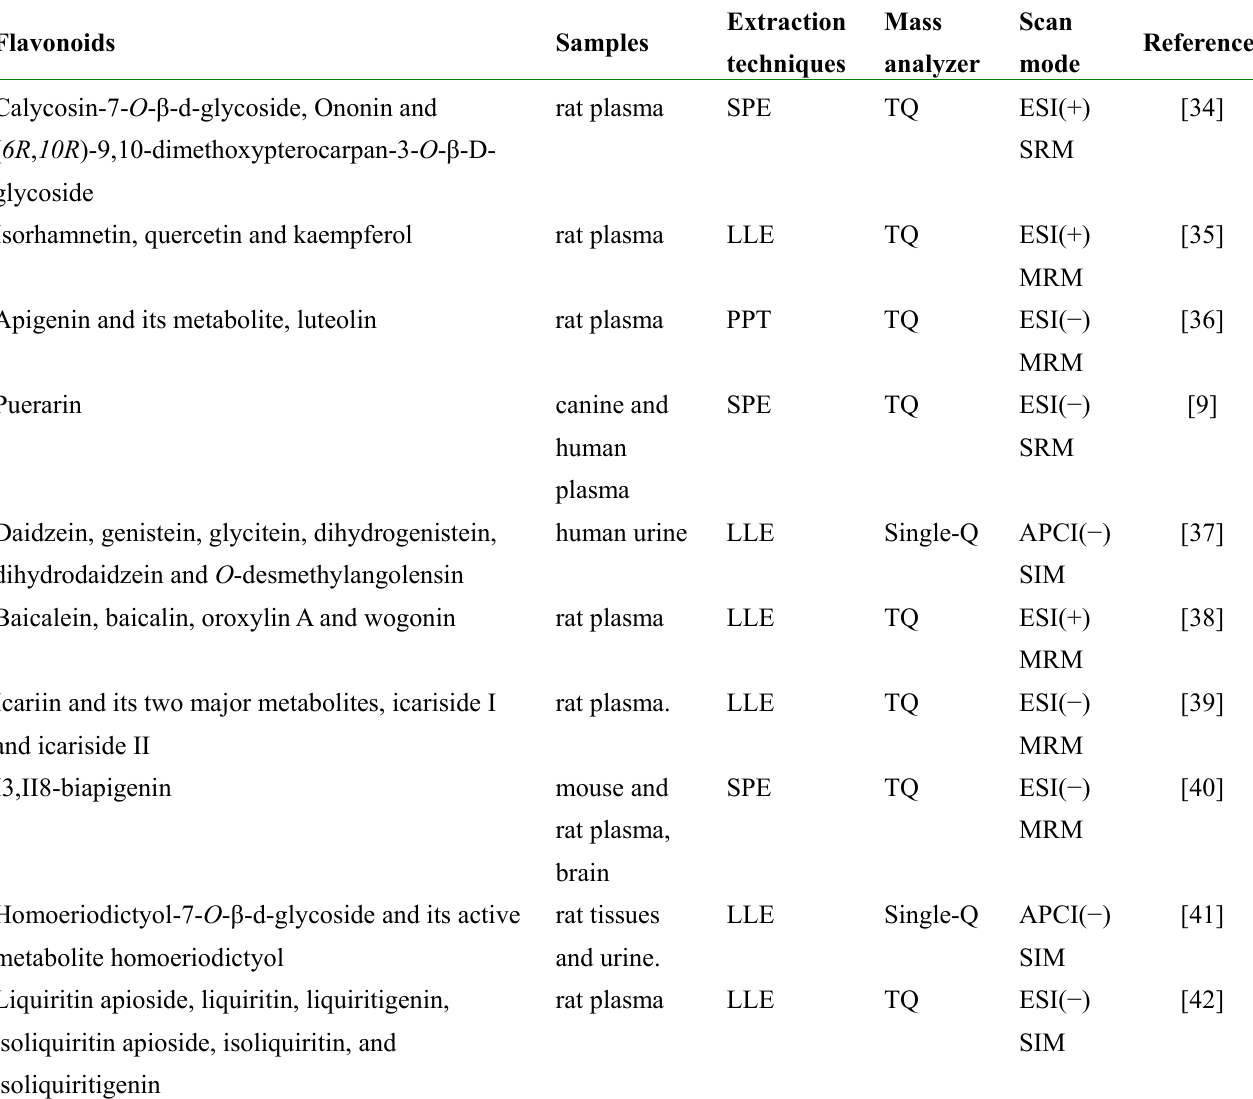
Table 2. Recent publications on in vivo analysis by